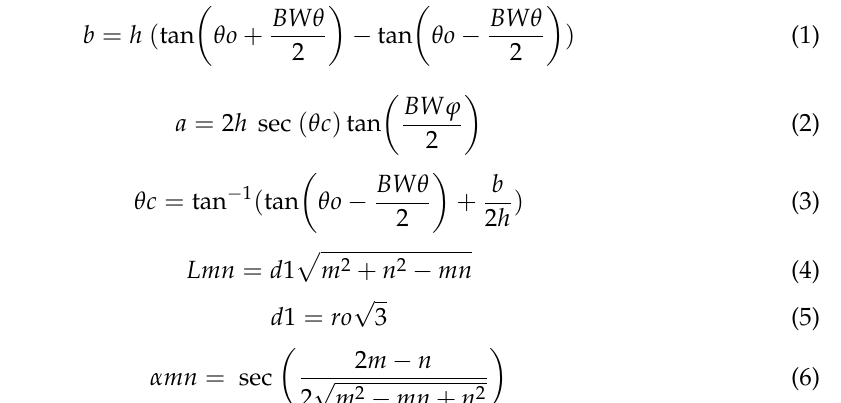
Figure 5. Co-ordinate system of a UAV’s cellular structure. Equations (1)–(6) represent the cellular structure design using beamforming and a smart MIMO antenna.